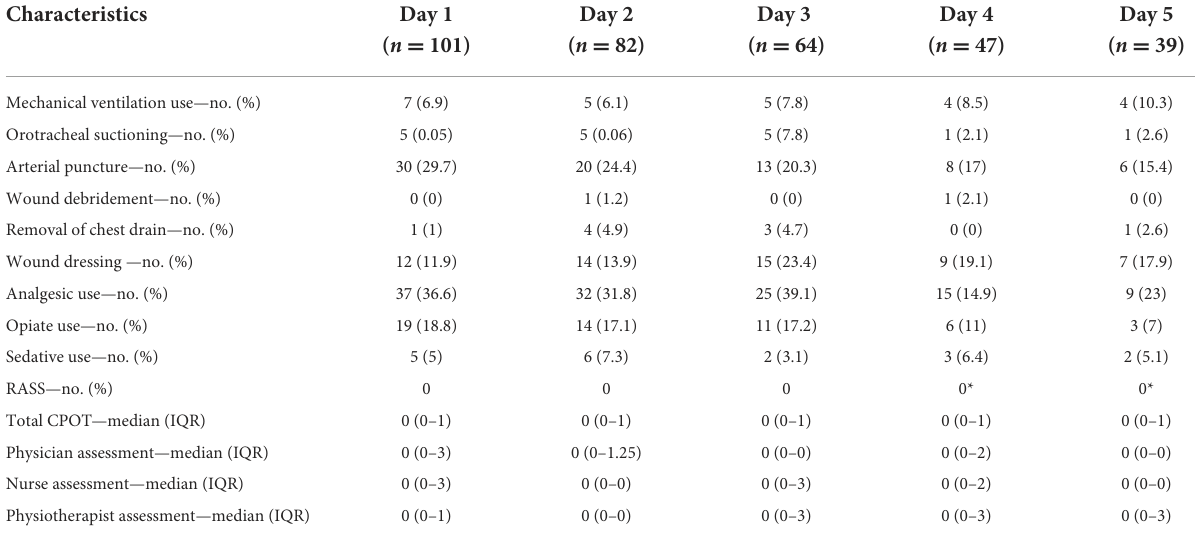
TABLE 2 Pain evaluation and procedures at each day. Characteristics